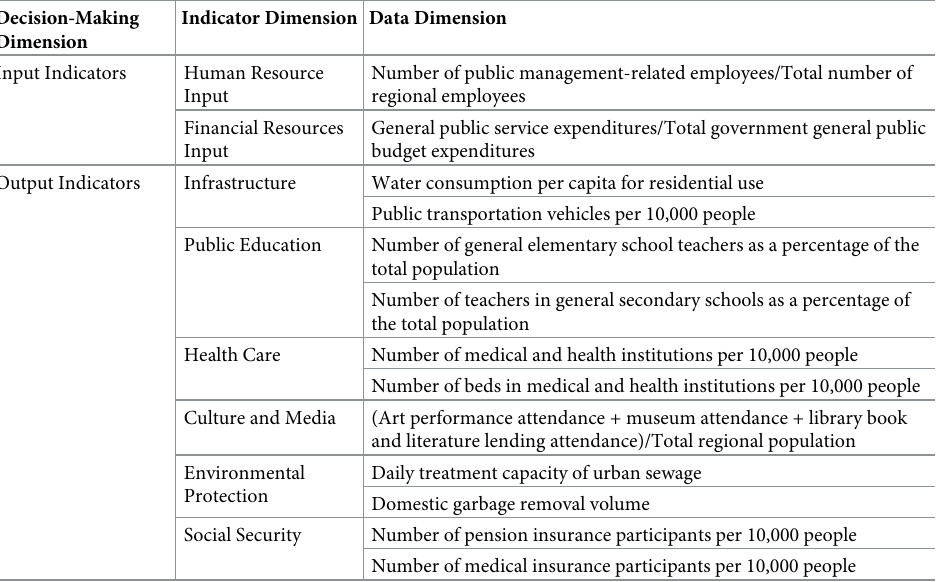
Table 1. Government public service supply efficiency evaluation index